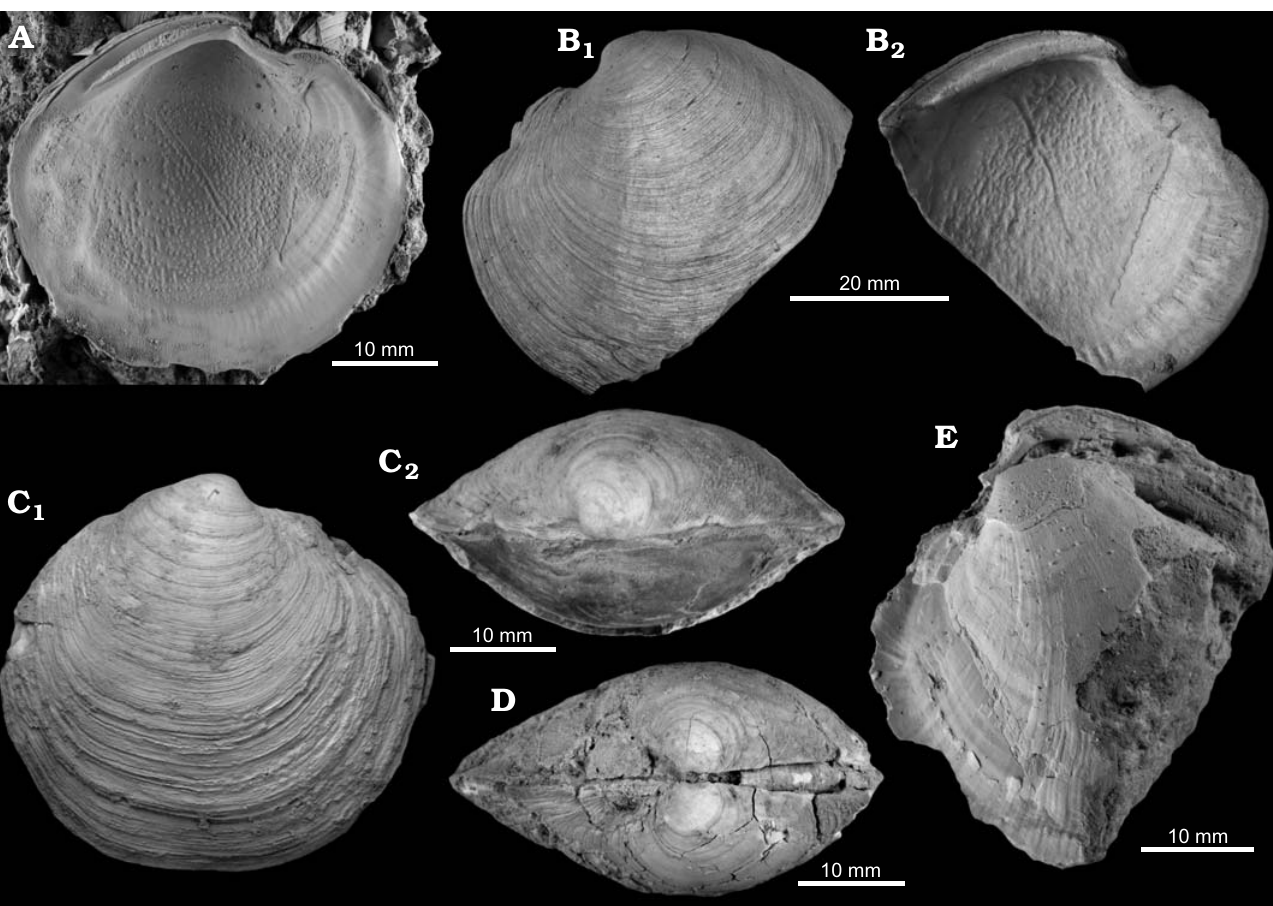
Fig. 5. The lucinid bivalve Megaxinus stironensis sp. nov. from the late Pliocene of Italy, Stirone River seep deposit. A . MGGC.22010, interior of left valve. B . MGGC.22011, exterior (B 1 ) and interior (B 2 ) of left valve of a large specimen. C . MGGC.22012, exterior of right valve (C 1 ) and dorsal view (C 2 ) of articulated specimen. D . NRM Mo184001, apical view of articulated specimen. E . MGGC.22013, internal mold showing strong radial striation on the thin veneer of remaining shell; this type of preservation is not uncommon at the Stirone